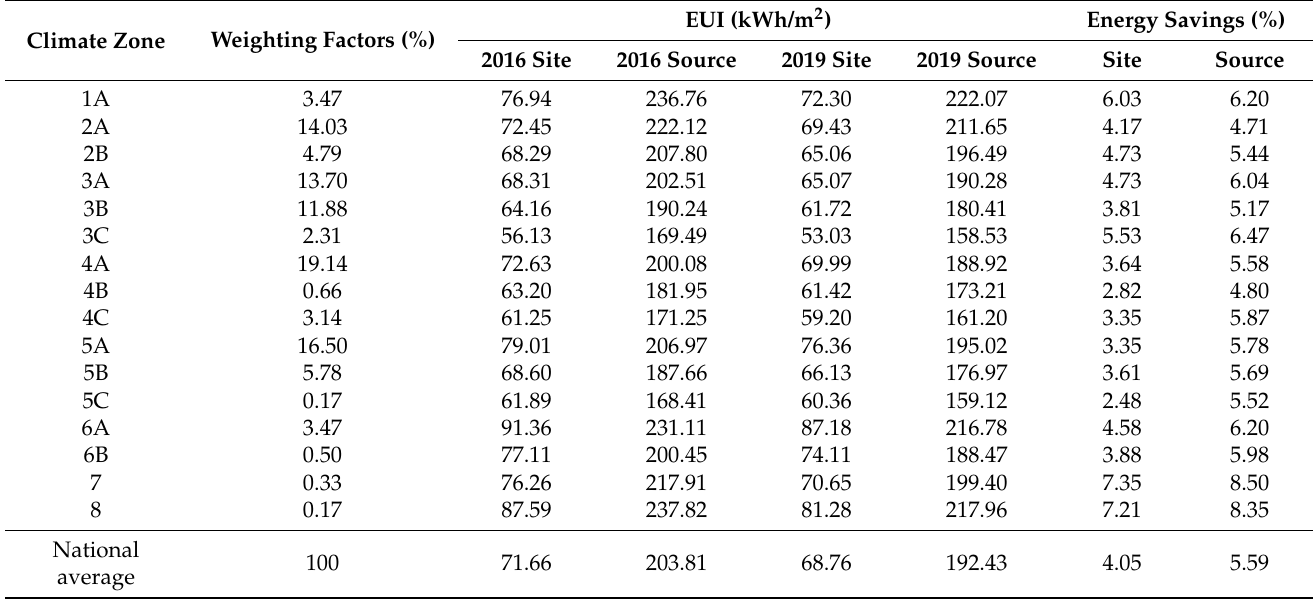
Table 8. The EUI and energy savings for the austerity behavior style.